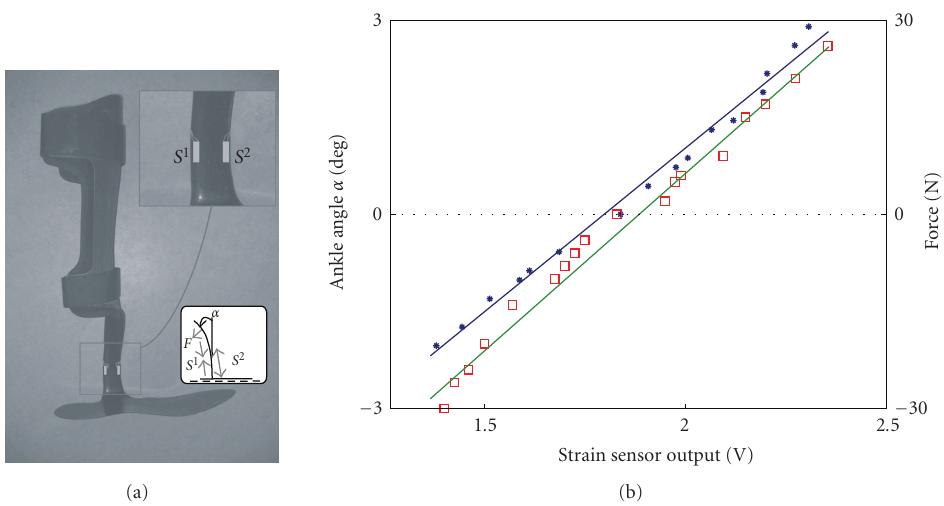
Figure 1: (a) Strain measurement setup. One strain gauge sensor S 1 is attached partly on the inside at the back and one S 2 partly on the inside at the front. Sensors S 3 and S 4 are attached at the corresponding positions but on the outside. (b) Measured ankle angle α (stars) and force F (squares) relation to AFO strain sensor output. Estimated linear relations: solid ( α ) and dashed